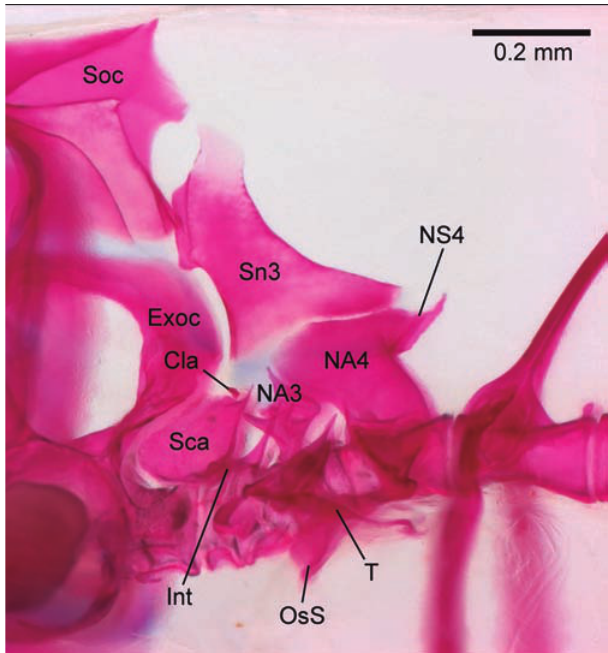
Fig. 4 . Priocharax nanus , paratype, MZUSP 114015, 14.9 mm SL, c&s; Weberian apparatus in lateral view. Cla = claustrum; Exoc = Exoccipital; Int = intercalarium; NA3-4 = neural archs3-4; NS4 = neural spine 4; OsS = os suspensorium; Sca = scaphium; Sn3 = supraneural 3; Soc = supraoccipital; T = tripus. Scale bar = 0.2